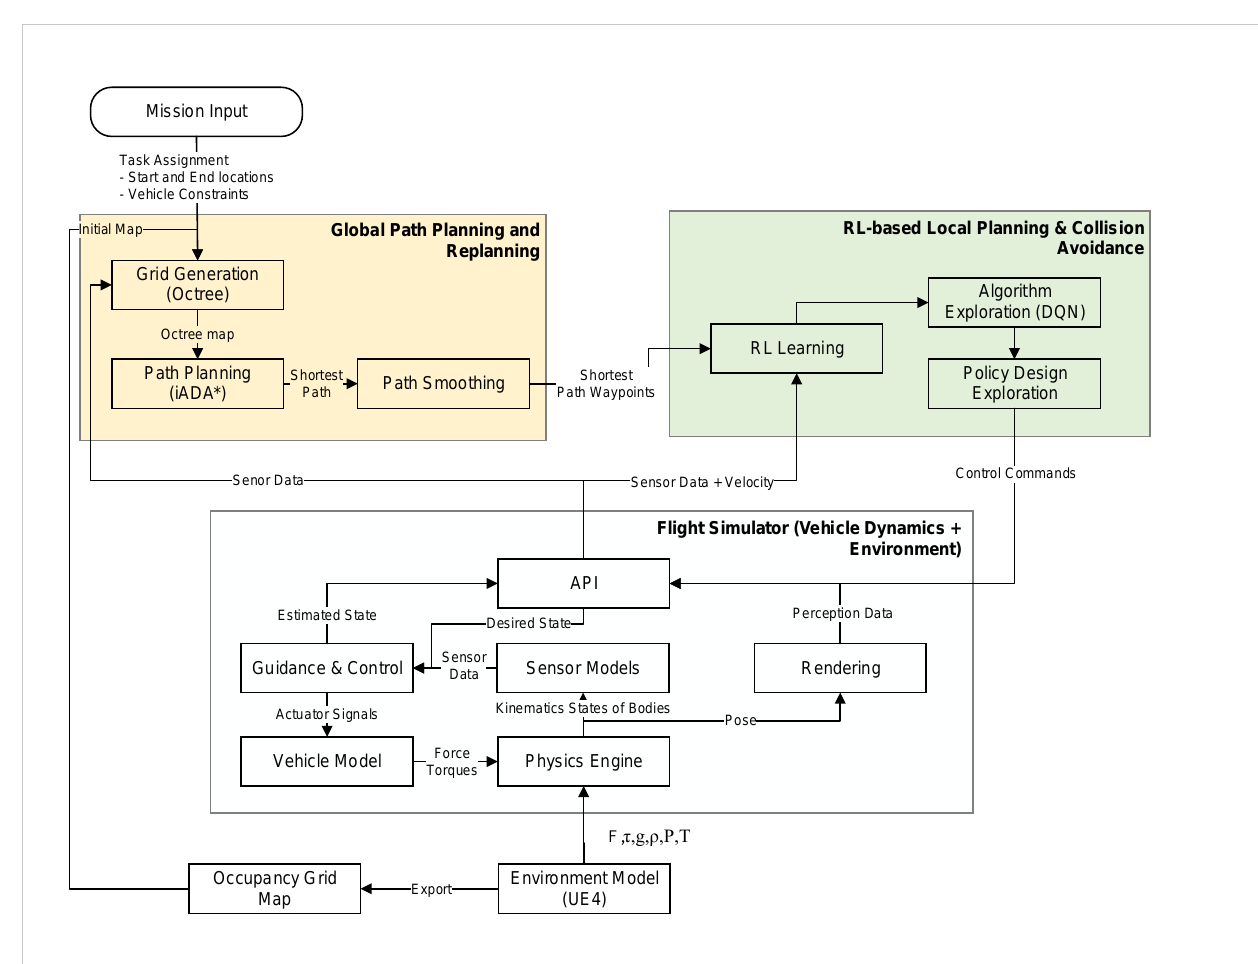
Figure 3. Proposed architecture of the hybrid path planning